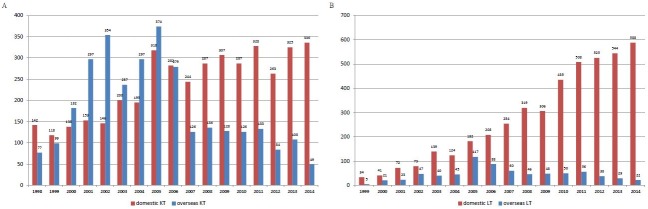
Number of domestic vs overseas transplants, 1998–2014.(A) Kidney transplants, 1998–2014 (Cochran-Armitage trend test P < 0.0001). (B) Liver transplants, 1999–2014 (Cochran-Armitage trend test P < 0.0001). KT = kidney transplant. LT = liver transplant. The numbers from 1998–2009 and 2010–2014 were obtained from NHIRD and TORSC, respectively. The numbers in 2009 would be incomplete since some recipient data were not available until in 2010 NHIRD.